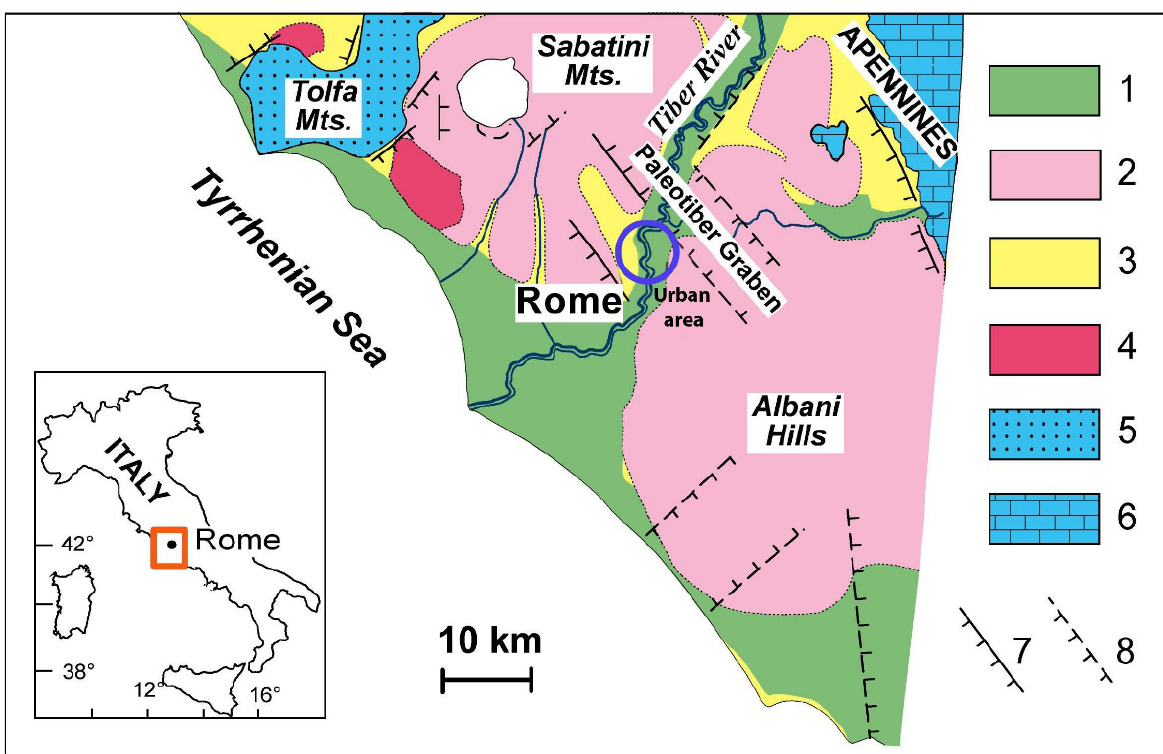
Figure 1. Geological setting of the study area and related depositional sequences. 1. Fluvial, coastal and shallow marine deposits; 2. Middle Pleistocene volcanites; 3. Coastal and shallow marine deposits; 4. Upper Pliocene volcanites; 5. Silicoclastic successions (Cretaceous-Eocene); 6. Carbonate successions (Trias-Miocene); 7. Normal fault; and 8. Buried normal fault.